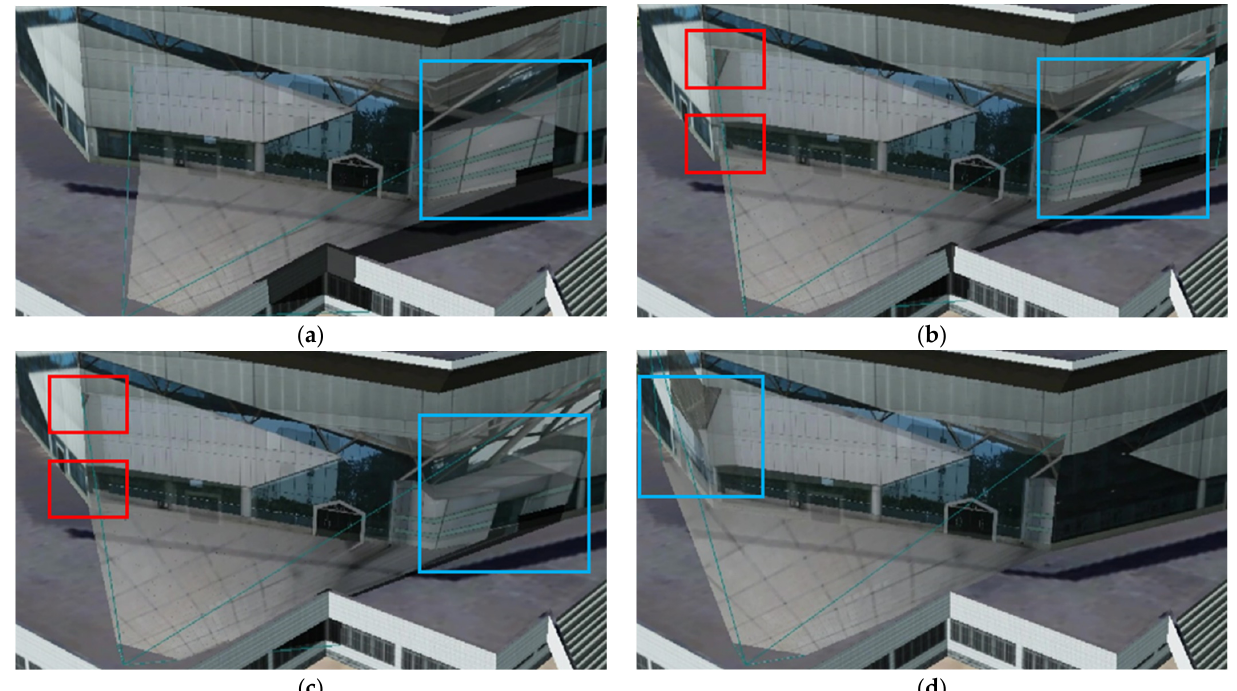
Figure 12. Experimental results of dynamic projection texture mapping at different moments under low transparency. ( a – d ) show the results of the dynamic fusion at different moments of low trans- parency. The red boxes show the error characteristics with respect to the distance from the line of sight. The blue boxes indicate the error characteristics related to the depth of projection.